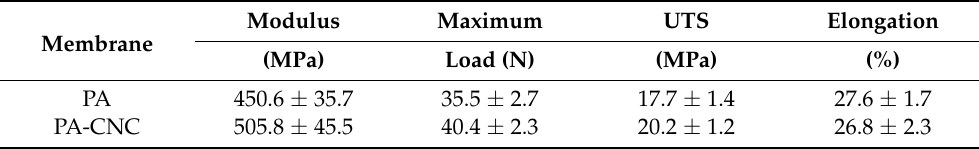
Table 3. Mechanical characterization of both PA and PA-CNC membranes.